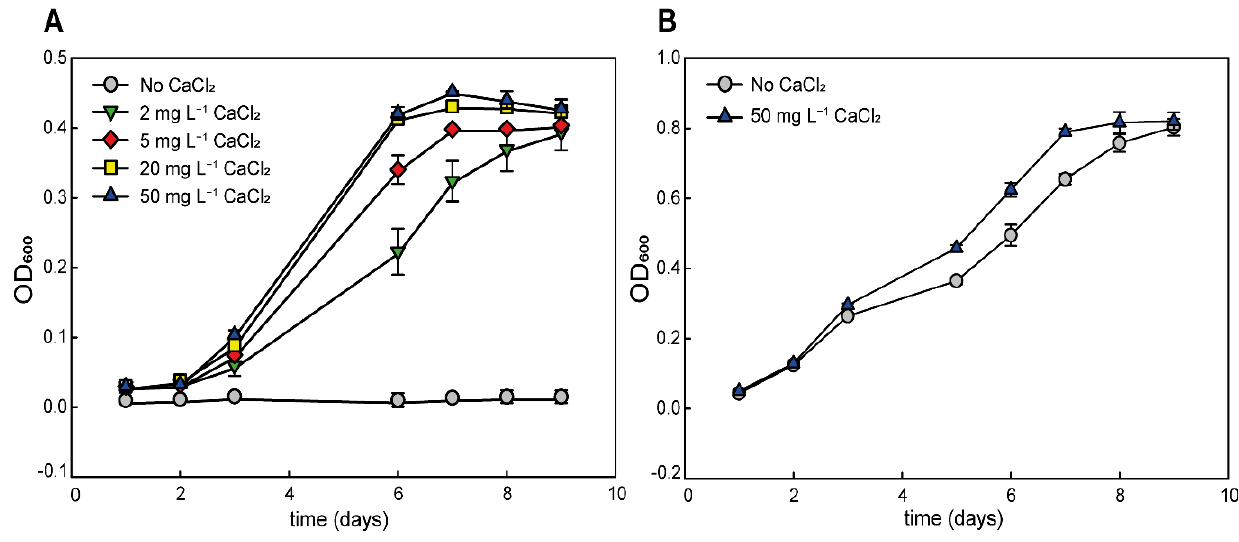
Figure 2. ( A ) Growth rate of G. phototrophica grown in liquid media with different CaCl 2 concentra- tions. ( B ) Growth rate of G. groenlandica in medium with 50 mg CaCl 2 L − 1 and in medium without added CaCl 2 .